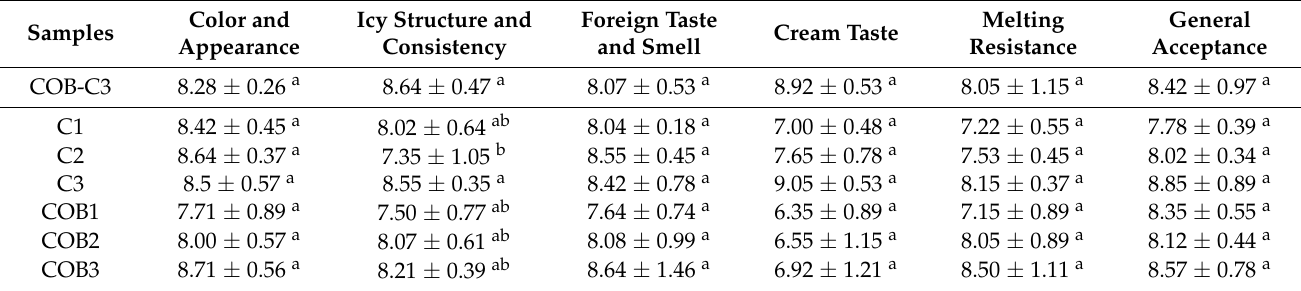
Table 7. Sensorial properties of the plant-based ice cream